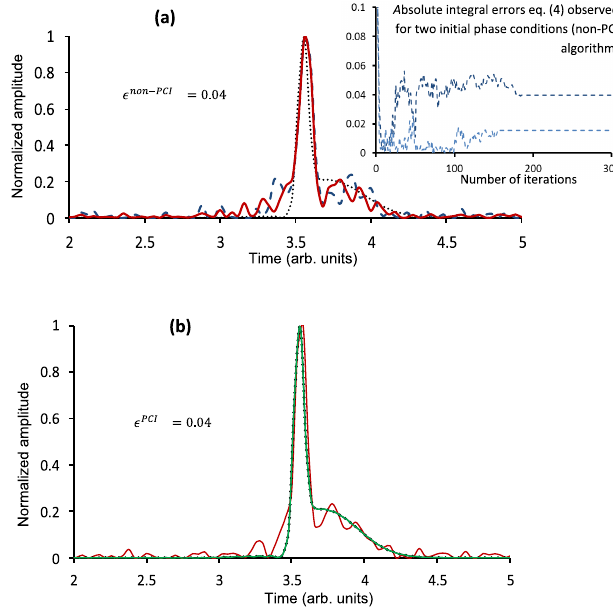
FIG. 2. Reconstruction of a synthetic function (black dotted line) generated by the superposition of two Gaussian functions with widths ( σ ) and amplitudes ( A ) given by A 1 ¼ 1 ; A 2 ¼ 0 . 2 ; i i σ ¼ 0 . 03 ; σ ¼ 0 . 21 ; t ¼ 0 . 17 ; t ¼ 0 . 37 . The reconstructions 1 2 1 2 are based on: (a) a non-PCI algorithm (the solid and dashed lines show the profiles that are reconstructed when using two different randomly generated sets of initial phases); (b) the PCI (solid red line) and minimal phase (solid green line) algorithms. The dotted black line indicates the original function. The inset to (a) illustrates the absolute integral errors (4) for both realizations shown in (a), illustrating the variation of the convergence trajectory with different initial phases.